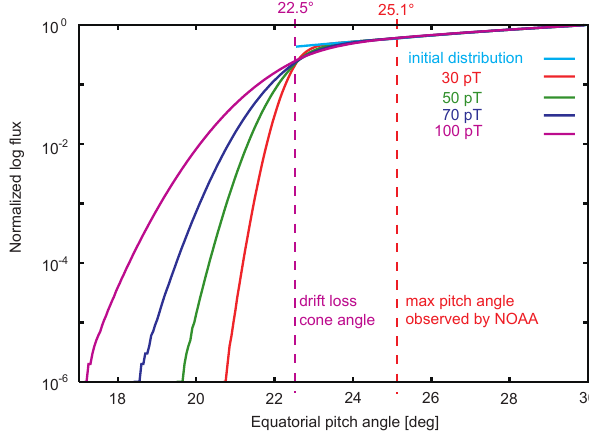
Fig. 9. Bounce averaged pitch angle diffusion coefficients for var- ious whistler mode waves with 300keV electron at L =2.0, NOAA altitude. The solid green, blue, and pink lines indicate, band whistler mode waves, VLF transmitters at 17.1kHz, and 22.3kHz, respectively.